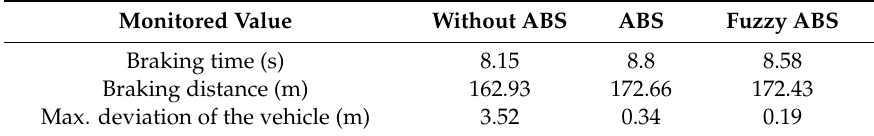
Figure 16. Maneuverability test on dry road at speed 130 km/h—( a ) Speed curve; ( b ) Braking distance; ( c ) Vehicle trajectory. Table 8. Maneuverability test on dry road at speed 130 km/h.